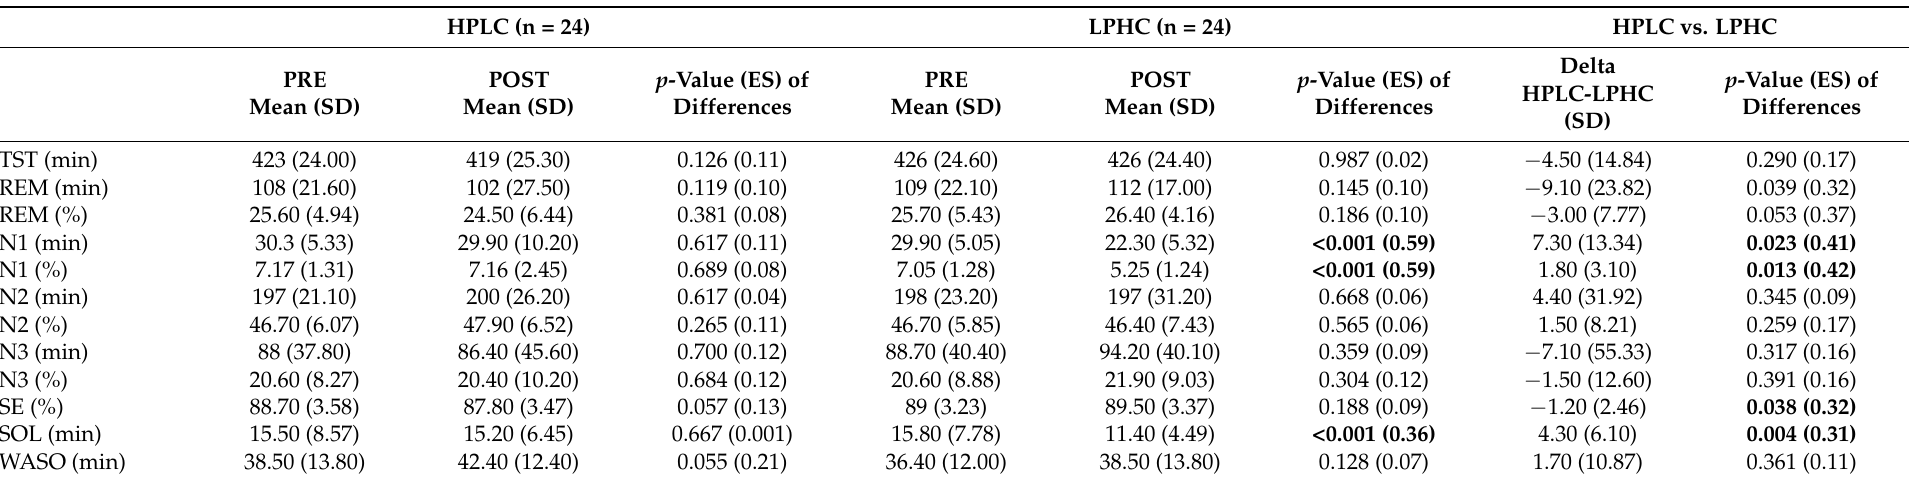
Table 2. Effect of HPLC vs. LPHC diets on sleep quality and